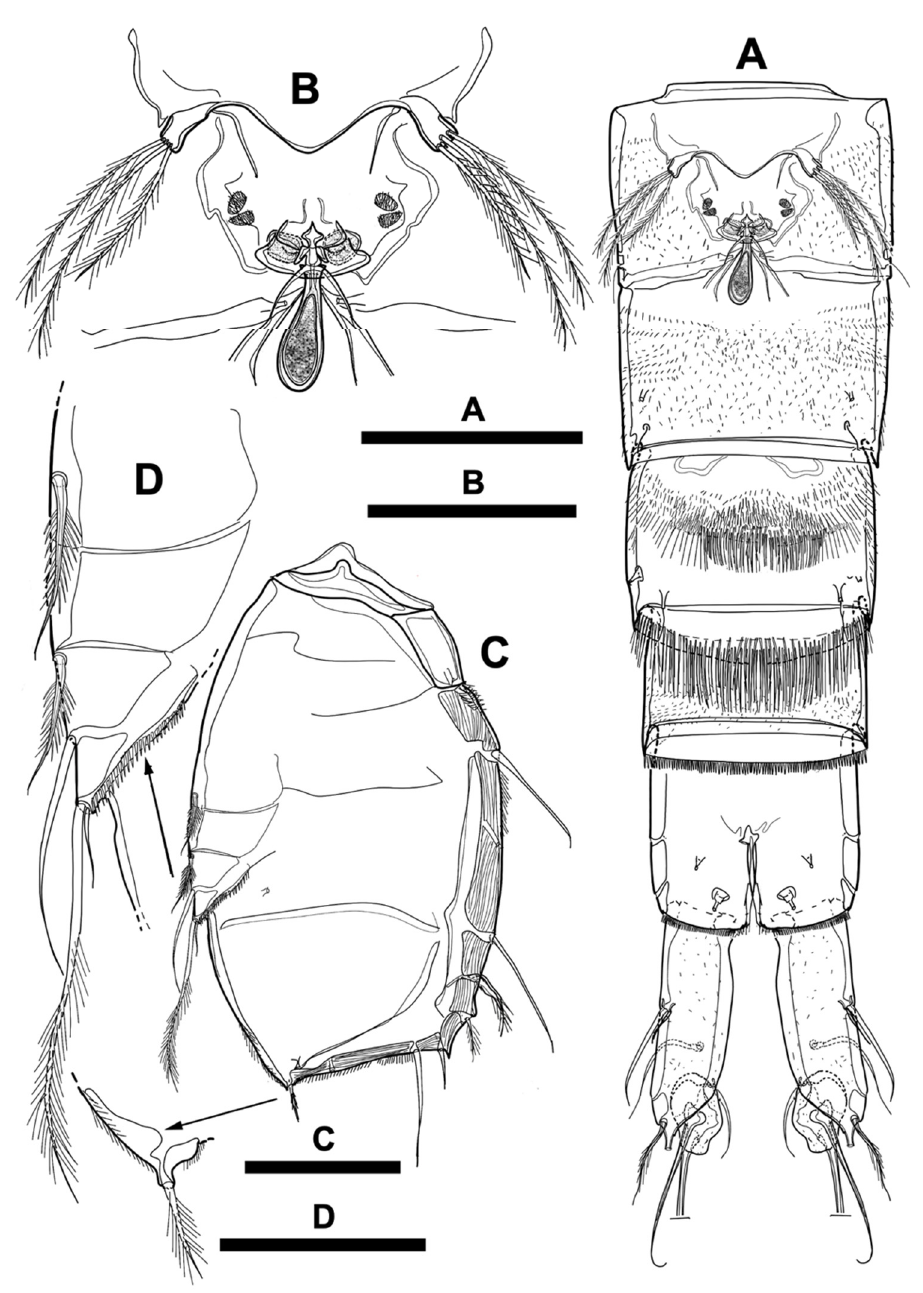
Figure 9. Line drawings of Phyllopodopsyllus saywakimi sp. nov. female (holotype): ( A ) urosome excluding first urosomite, ventral; ( B ) genital field; ( C ) fifth pereiopod; ( D ) former baseoendopod of the fifth pereiopod. Scale bars: ( A , C ) 100 µm; ( B , D ) 50 µm.